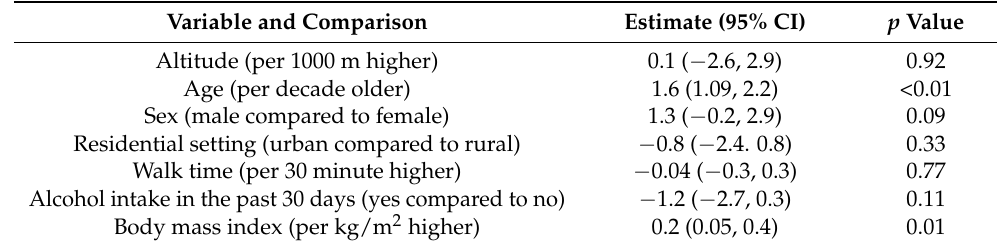
Table 4. Estimates of the mean glycated hemoglobin (HbA1c) for altitude in a multivariate ANCOVA and associations for confounding